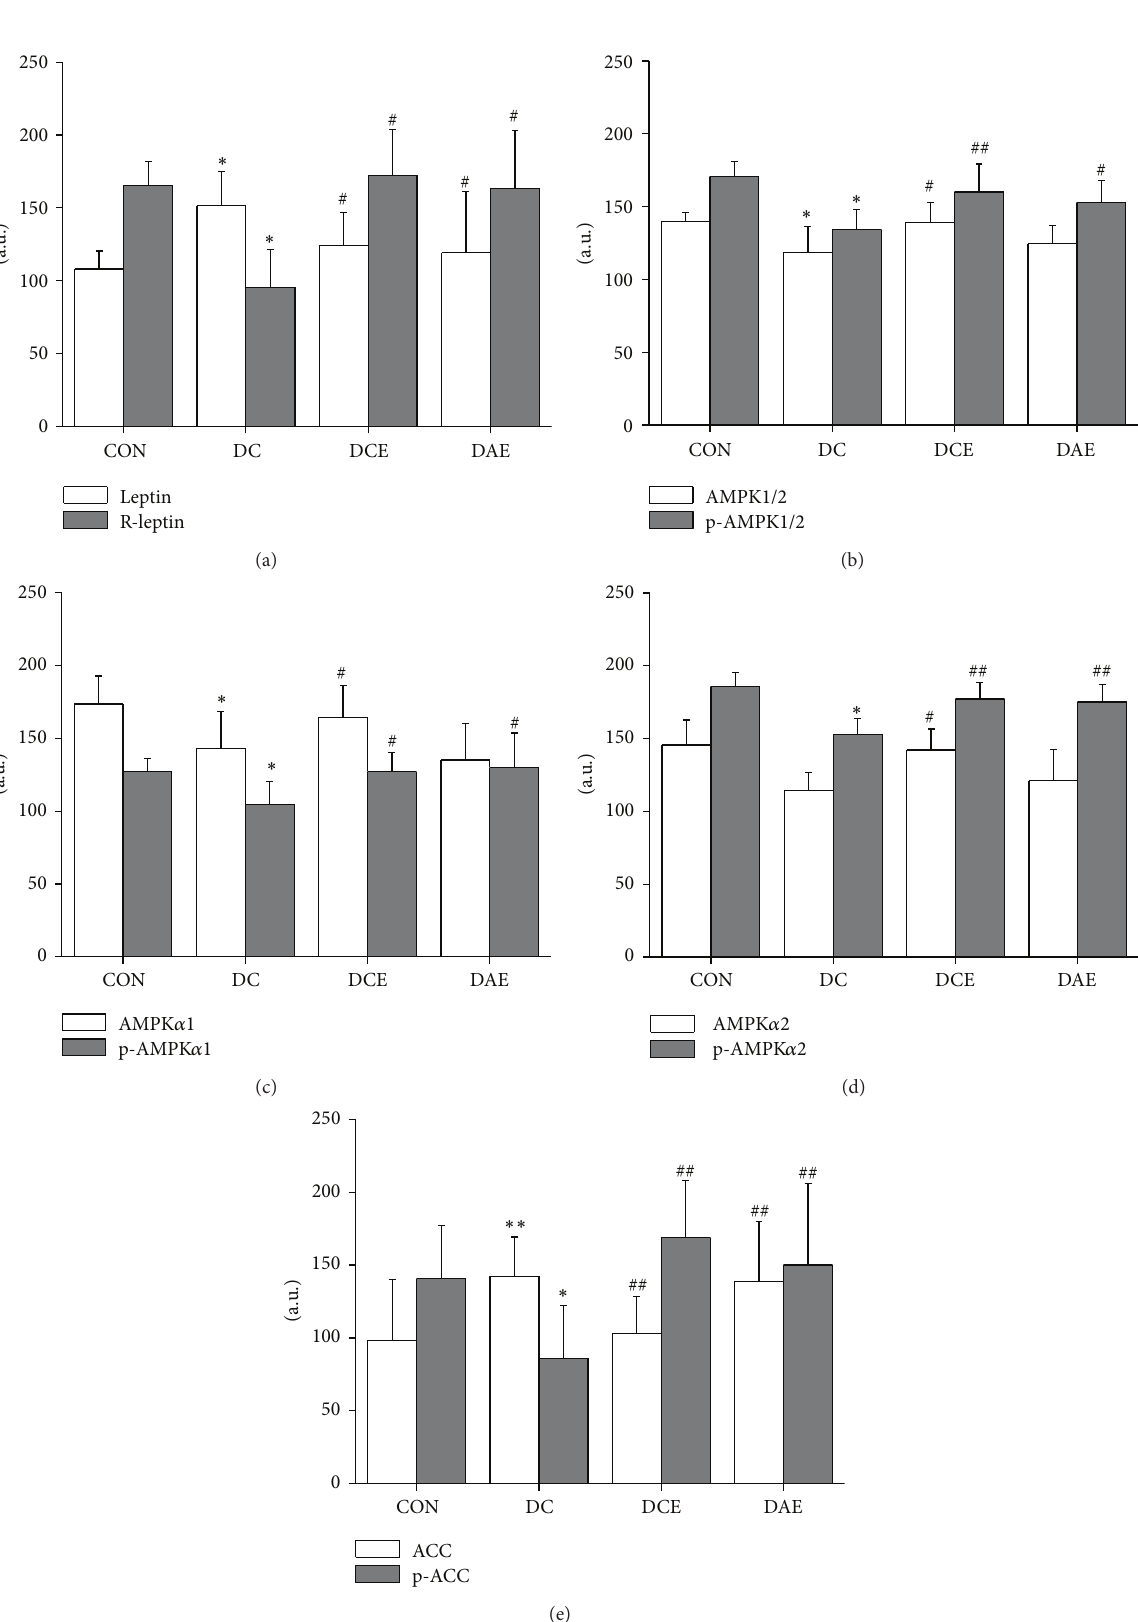
Figure 1: Histograph showing the effects of exercise on the leptin-AMPK-ACC pathway in type 2 diabetes rats. The relative levels of protein phosphorylation and protein expression related to the leptin-AMPK-ACC signaling pathway on different groups were shown. (a) Leptin and its receptor. (b) AMPK1/2 and p-AMPK1/2 (Thr 172 ). (c) AMPK 𝛼 1 and p-AMPK 𝛼 1 (Thr 172 ). (d) AMPK 𝛼 2 and p-AMPK 𝛼 2 (Thr 172 ). (e) ACC and p-ACC (Ser 79 ). Note: in comparison with the control group: ∗∗ 𝑃 < 0.01 , ∗ 𝑃 < 0.05 ; in comparison with the diabetes group: ## 𝑃 < 0.01 , # 𝑃 < 0.05 ( 𝑛 = 8